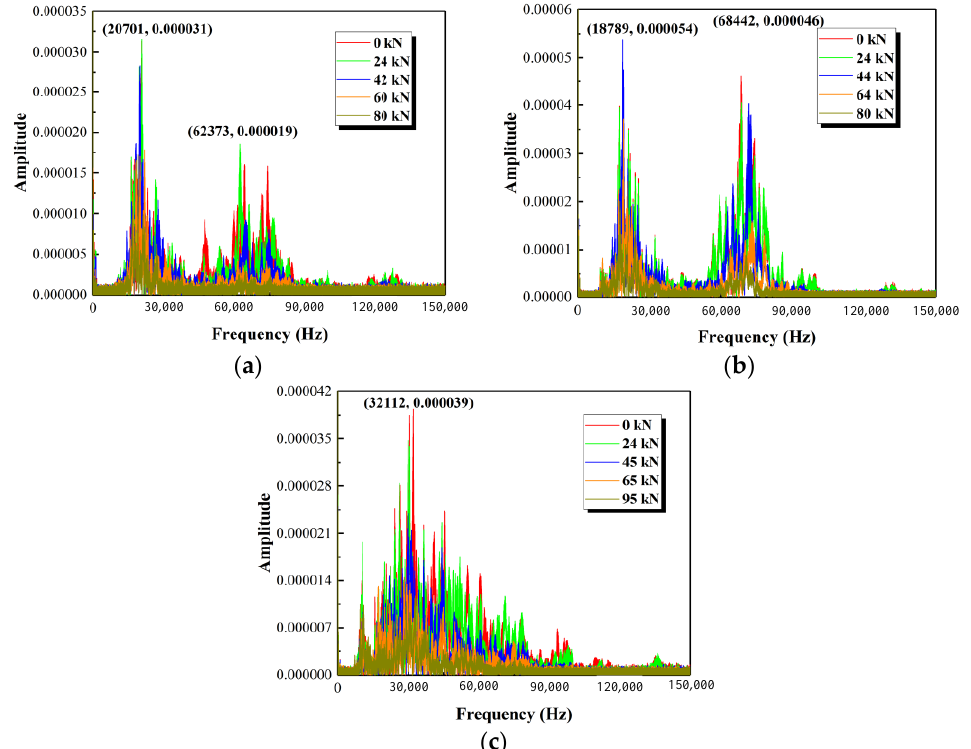
Figure 27. Frequency-domain diagrams for three test specimens. ( a ) Test specimen G1, ( b ) Test specimen G3, ( c ) Test specimen S1.